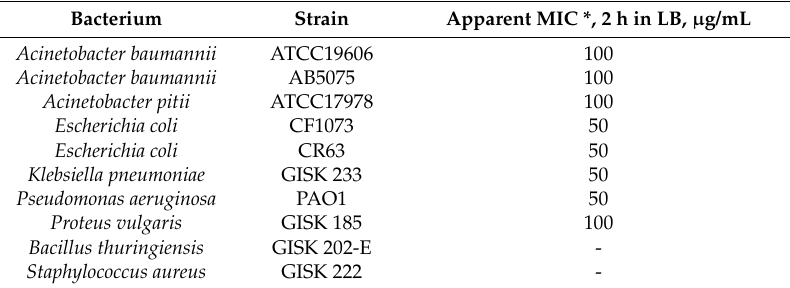
Table 1. AcLys substrate specificity